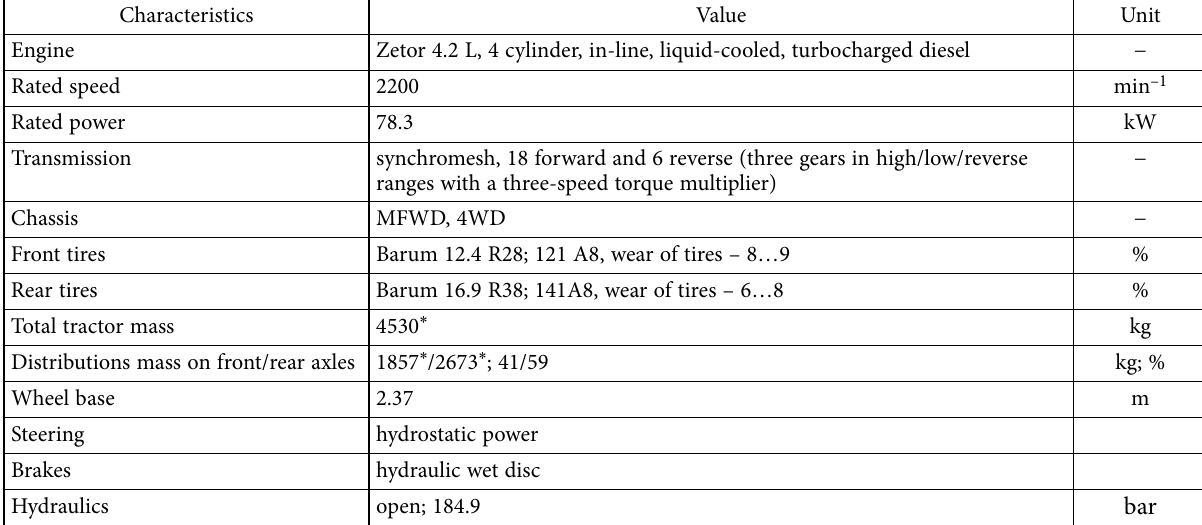
Table 1. Technical data of the Zetor 10540 tractor